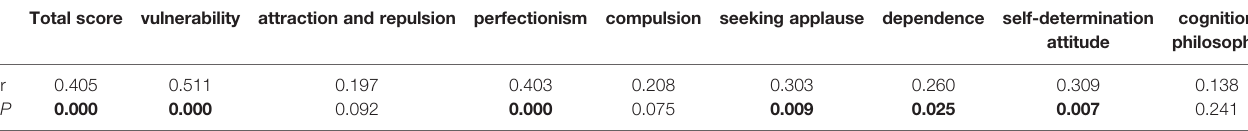
TABLE 5 | Correlations between the baseline and remission phase C-DAS-A total and factor scores in the rMDD subgroup. Total score vulnerability attraction and repulsion perfectionism compulsion seeking applause dependence self-determination